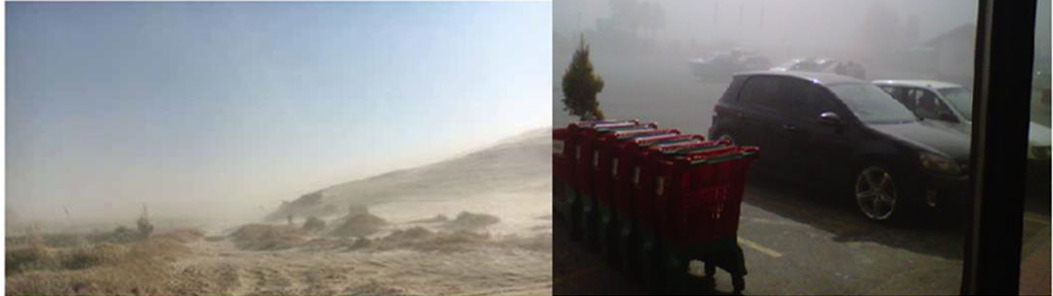
Figure 1. A windy day in the gold mine village [19].